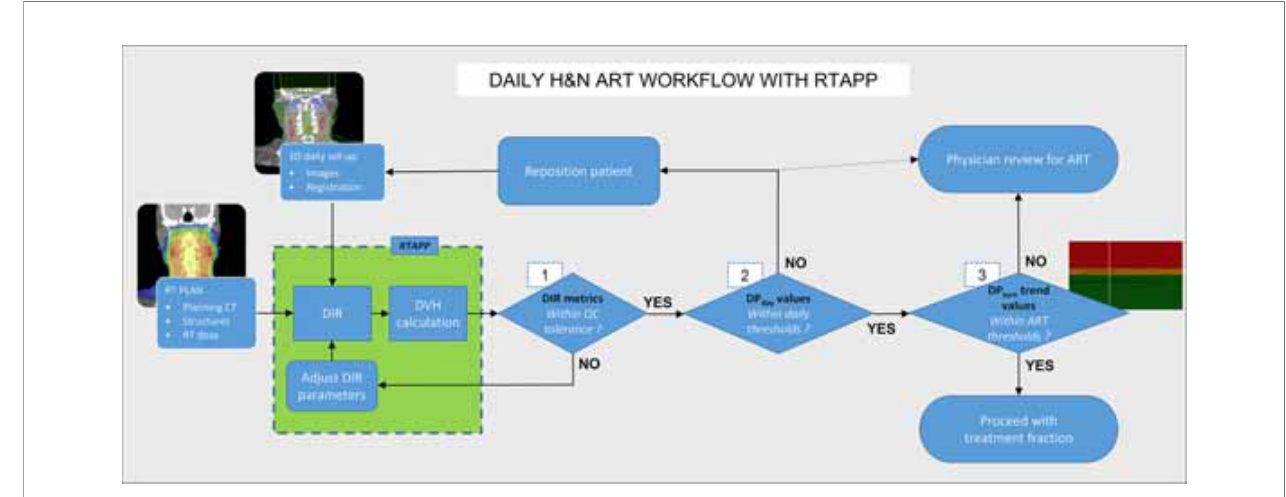
FIGURE 7 | Hybrid ART clinical work fl ow with RTapp. Decision steps 1 – 3 occur at the treatment console before treatment delivery. (1) RTapp fl ags structures with potential deformation issues. (2) The treatment team at the console reviews the DP day values against warning thresholds and might reposition the patient. (3) The current and predicted DP sum trends are reviewed prior treatment to assess whether the treatment adaptation is needed within the next four